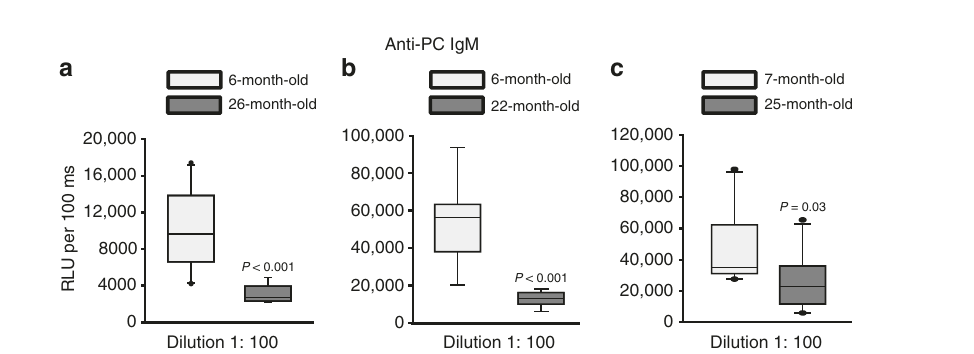
Quanti fi cation of cancellous and cortical bone mass as determined by micro-CT and histomorphometric analysis of cancellous bone in 11-month-old mice fed a normal diet. n = 4, 2 females and 2 males per genotype. Data shown represent the mean (±SD). Data were analyzed by two-tailed Student ’ s t -test BV/TV Bone volume/total volume, BFR/BS bone formation rate/bone surface, N.Oc osteoclast number, B. Pm bone perimeter, NS not signi fi cant